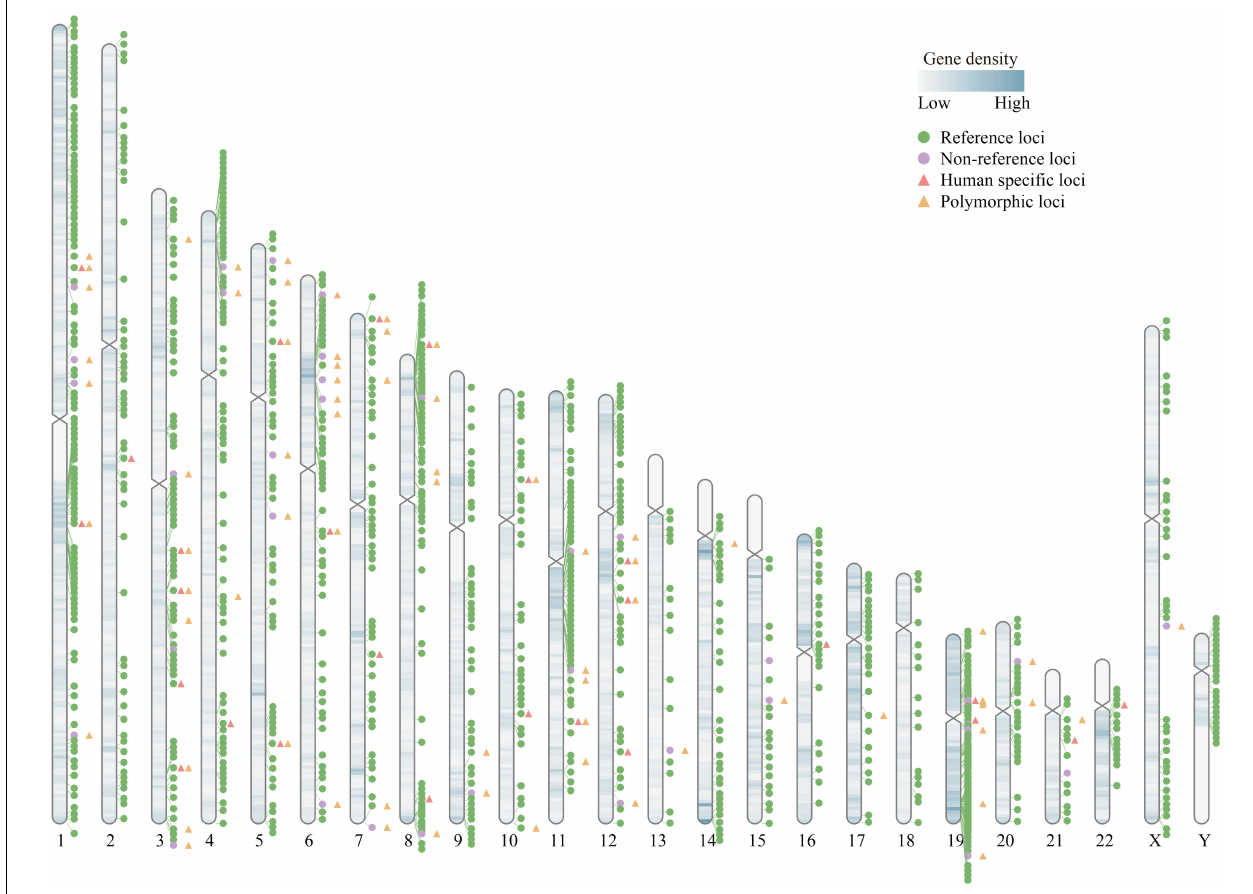
Frontiers in Microbiology |